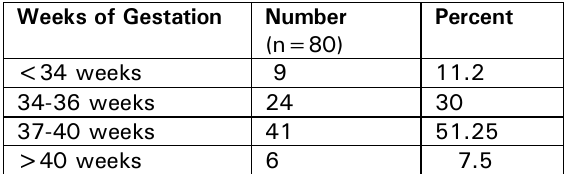
Table 3 : Gestational age at delivery